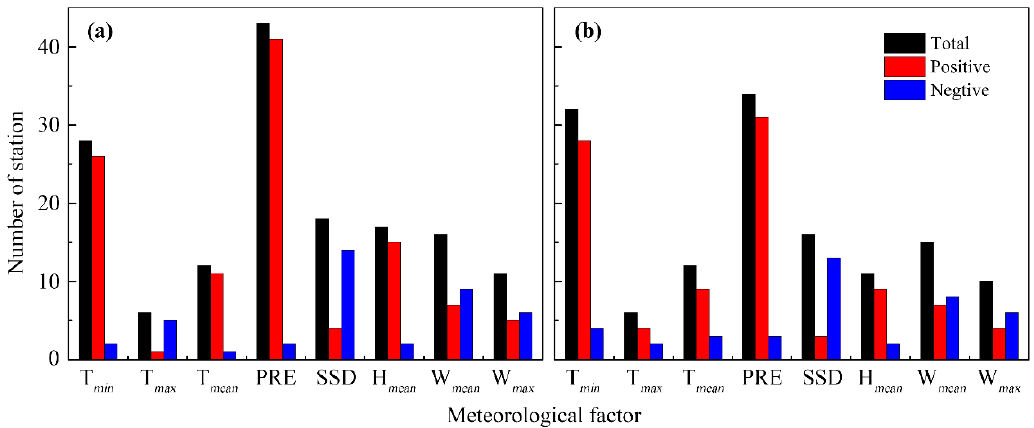
Figure 4. Number of stations and regression coefficient sign symbols for climatic variables selected by stepwise linear regression models for ( a ) NDVI- and ( b ) EVI2-retrieved MSD. T min , T max , T mean , PRE, SSD, H mean , W mean , and W max denote the daily minimum, maximum, mean air temperature, accumulated precipitation, sunshine duration, mean relative humidity, mean, and maximum wind speed during the optimum length periods, respectively. The black bar is the total number of stations for the selected climate variables. The red and blue bar are the number of stations with positive and negative regression coefficients for the selected climate variables, respectively.